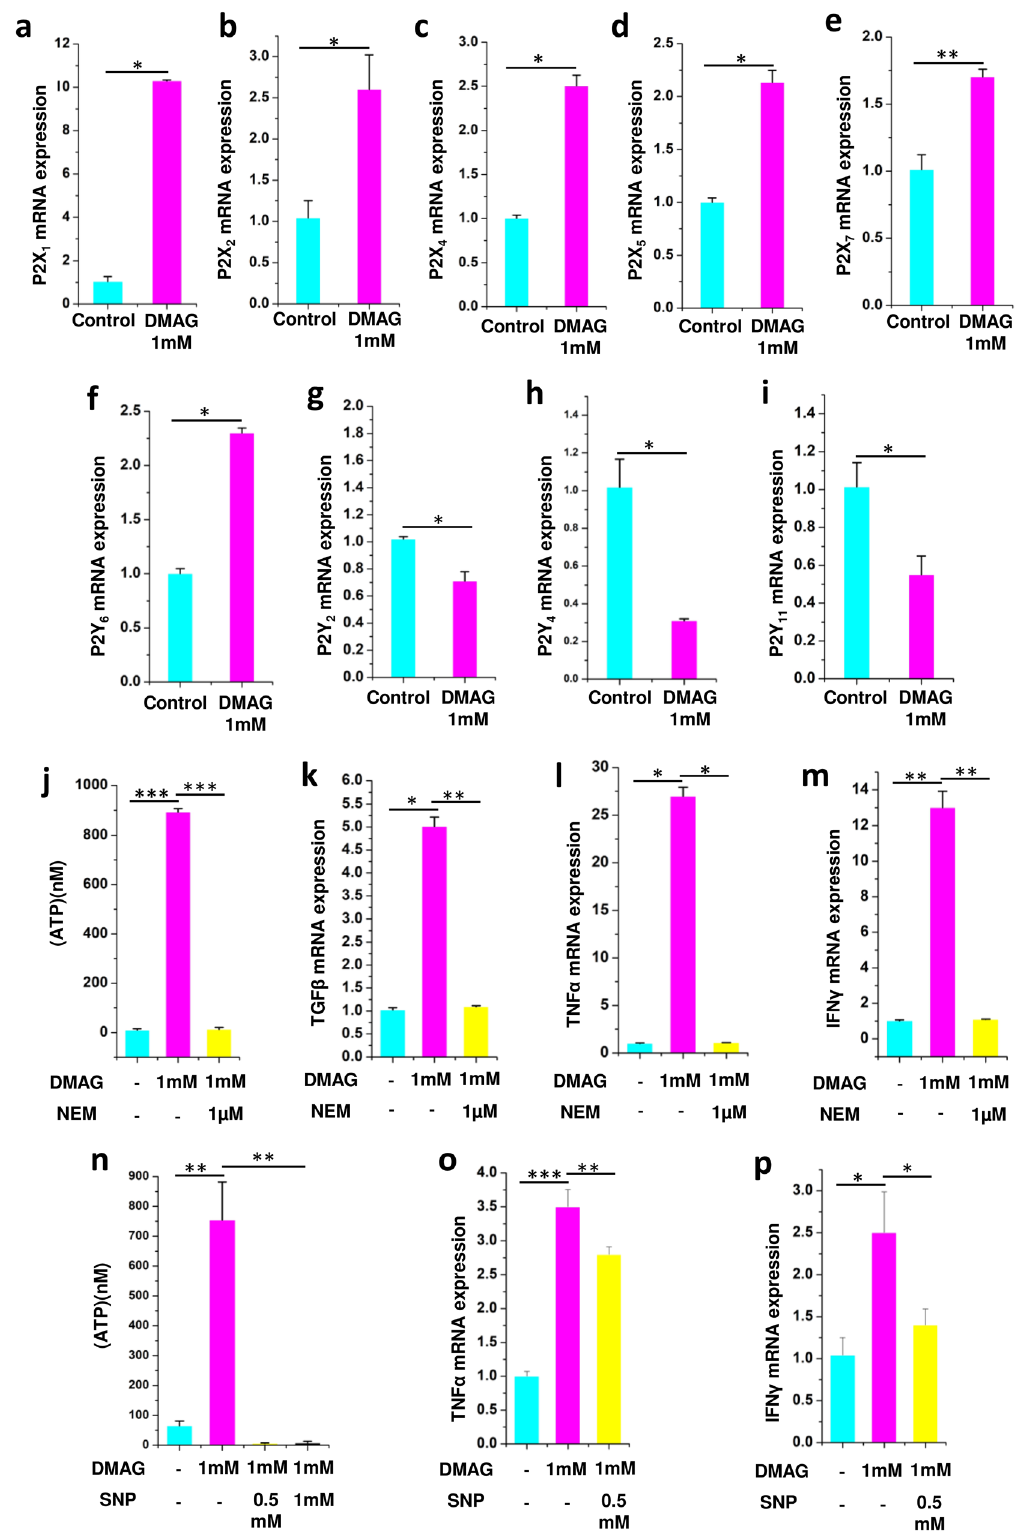
Figure 3. Showing expression of P2 receptors in N9 microglial cells and DMAG induced ATP secretion and expression of cytokines as well as effect of NEM and sodium nitroprusside (SNP) showing ( a – i ) N9 cells treated with DMAG inducing the expression of P2X receptors and P2Y receptors ( a ) P2X 1 ( b ) P2X 2 ( c ) P2X 4 ( d ) P2X 5 ( e ) P2X 7 ( f ) P2Y 6 ( g ) P2Y 2 ( h ) P2Y 4 ( i ) P2Y 11 . Showing N9 cells treated with DMAG (1 mM) with or without pre-incubation with NEM (1 μM) ( j ) Secretion of ATP and inhibited by NEM. Showing upregulation of cytokines and inhibition by NEM ( k ) TGFβ ( l ) TNFα ( m ) IFN ɣ . Showing N9 cells treated with DMAG (1 mM) with or without pre-incubation with SNP (0.5 mM and 1 mM) ( n ) secretion of ATP and its inhibition by SNP. Showing upregulation of cytokines and inhibition by SNP ( o ) TNFα ( p ) IFNy. The significance was calculated using Student T-test. * for P < 0.05, ** for P < 0.01, and *** for P < 0.001. For n numbers and the results provided as mean ± SEM, refer to